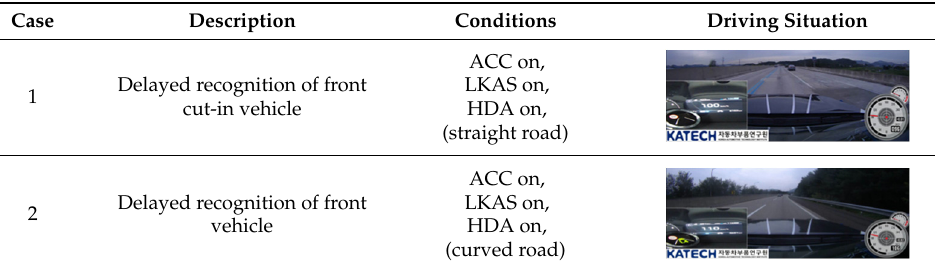
Table 14. Key situations in which the driver intervened among the identified events.